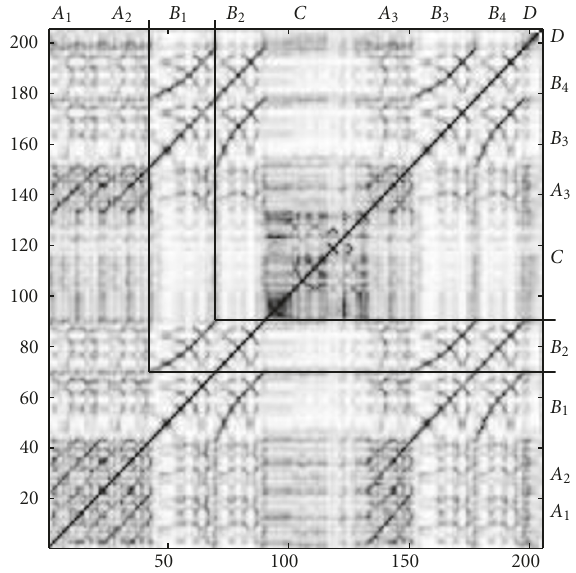
Figure 1: Self-similarity matrix S [41,10] of an Ormandy interpre- tation of Brahms’ Hungarian Dance no. 5. Here, dark colors corre- spond to low values (high similarity) and light colors correspond to high values (low similarity). The musical form A 1 A 2 B 1 B 2 CA 3 B 3 B 4 D is reflected by the path structure. For example, the curved path marked by the horizontal and vertical lines indicates the similarity between the segments corresponding to B 1 and B 2